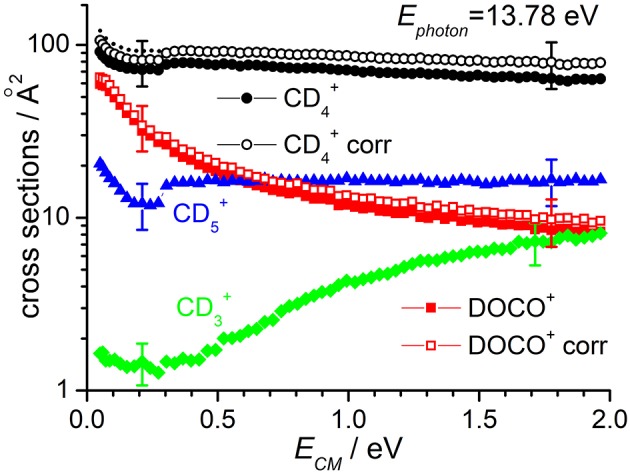
Reactive cross sections for products CD4+ (uncorrected, black circles), DOCO+ (uncorrected, red squares), CD3+ (green diamonds), and CD5+ (blue triangles) measured as a function of the collision energy (ECM) in the DC mode at a photon energy Ephot = 13.78 eV. The open black circles and open red squares are the CD4+ and DOCO+ cross sections corrected to include the contribution of secondary reactions leading to CD5+. The dotted line represents the CD4+ cross sections corrected for the instrumental effect due to decreased collection efficiency at low ECM (see text for details). Error bars on all the data are about 30%: for the sake of clarity only two error bars are reported, at arbitrarily chosen low and high collision energy values.